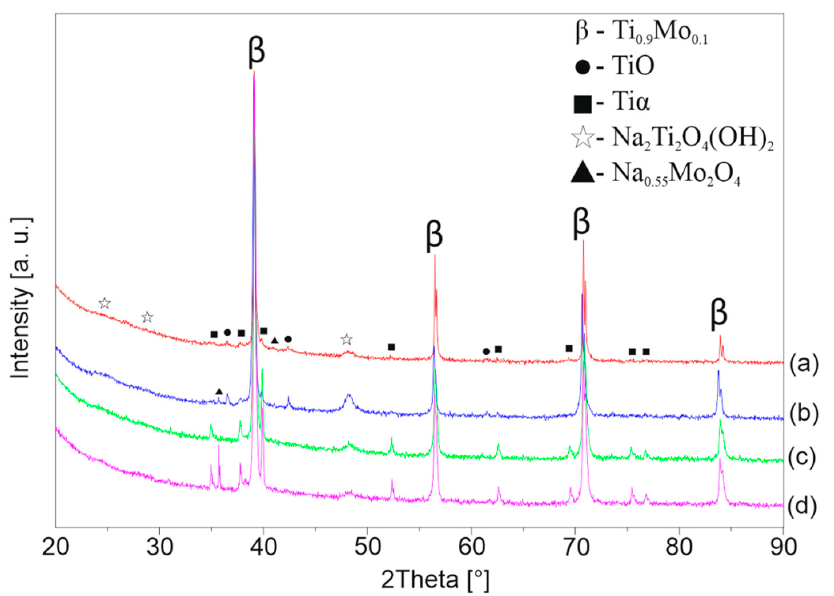
Figure 6. XRD patterns of Ti23Mo after alkaline treatment in ( a ) 5 M, ( b ) 7 M, ( c ) 10 M, ( d ) 12 M NaOH solutions.